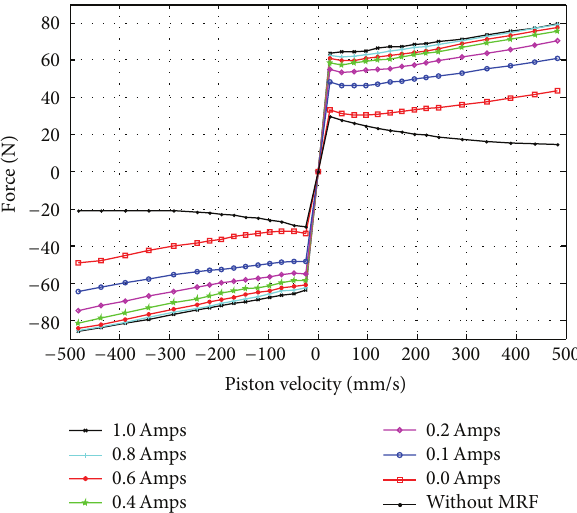
Figure 11: The prototype damper quasisteady tested force versus velocity